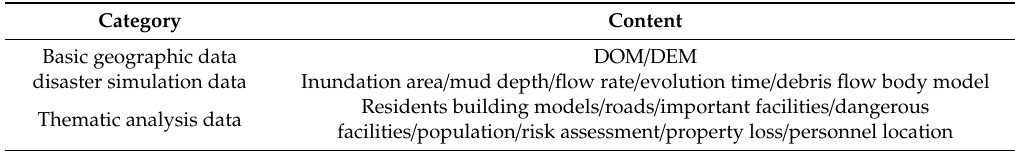
Table 2. Experimental